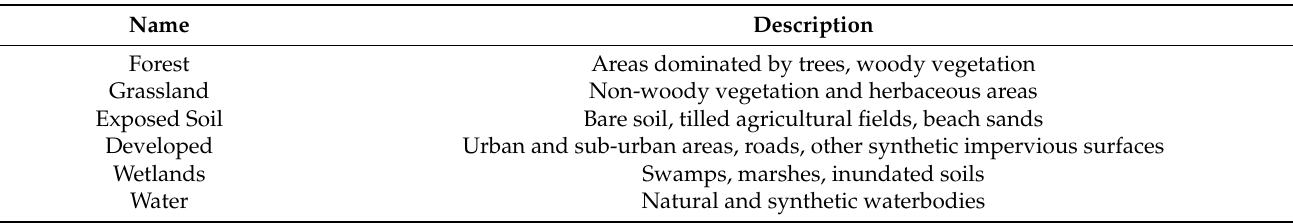
Table 1. Description of land cover classes.